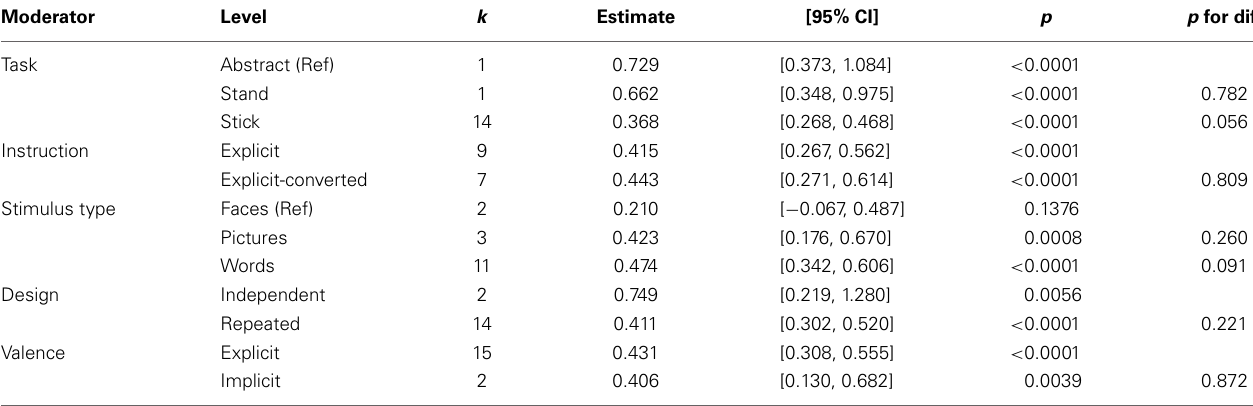
Table 6 | Results of subset analyses of both